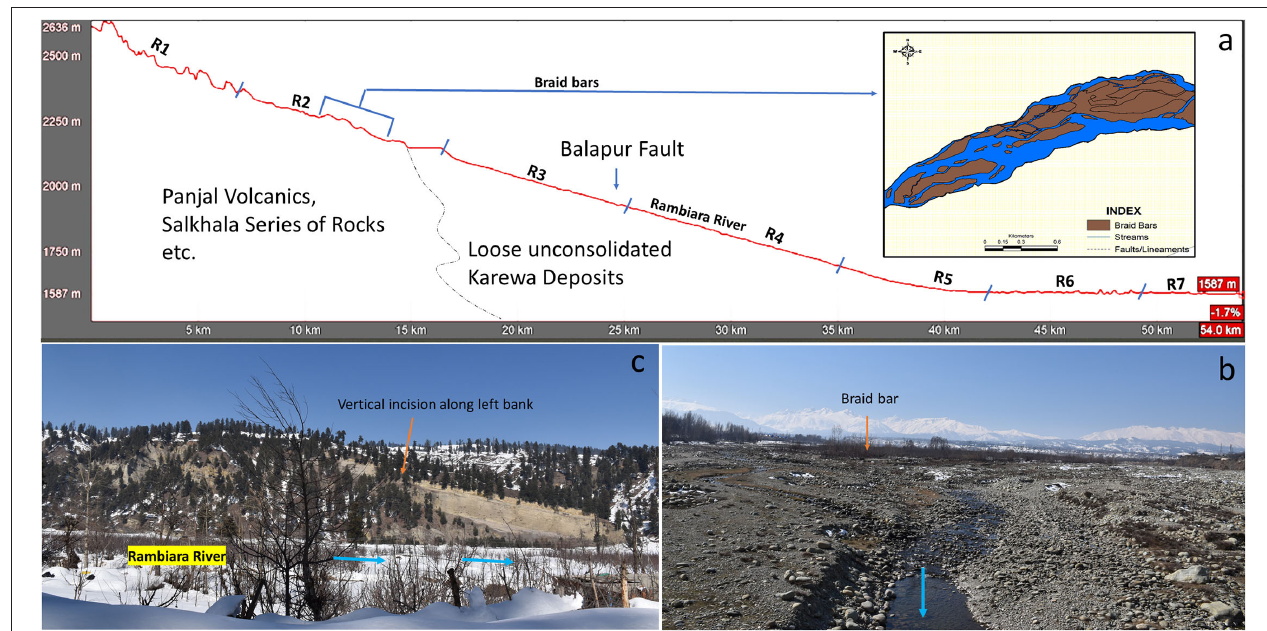
FIGURE 5 | (a) showing the longitudinal profile of the Rambiara river and the seven reaches into which the river was divided for calculating various geomorphic indices. Note the location of Balapur fault and the presence of other convexities in the longitudinal profile, the braid bars along a small reach are also shown, (b) the braid bar formed along the trace of the Balapur fault. The blue arrow shows the direction of river flow and (c) the vertical incision observed along the banks of the river near the Hirpur Village.